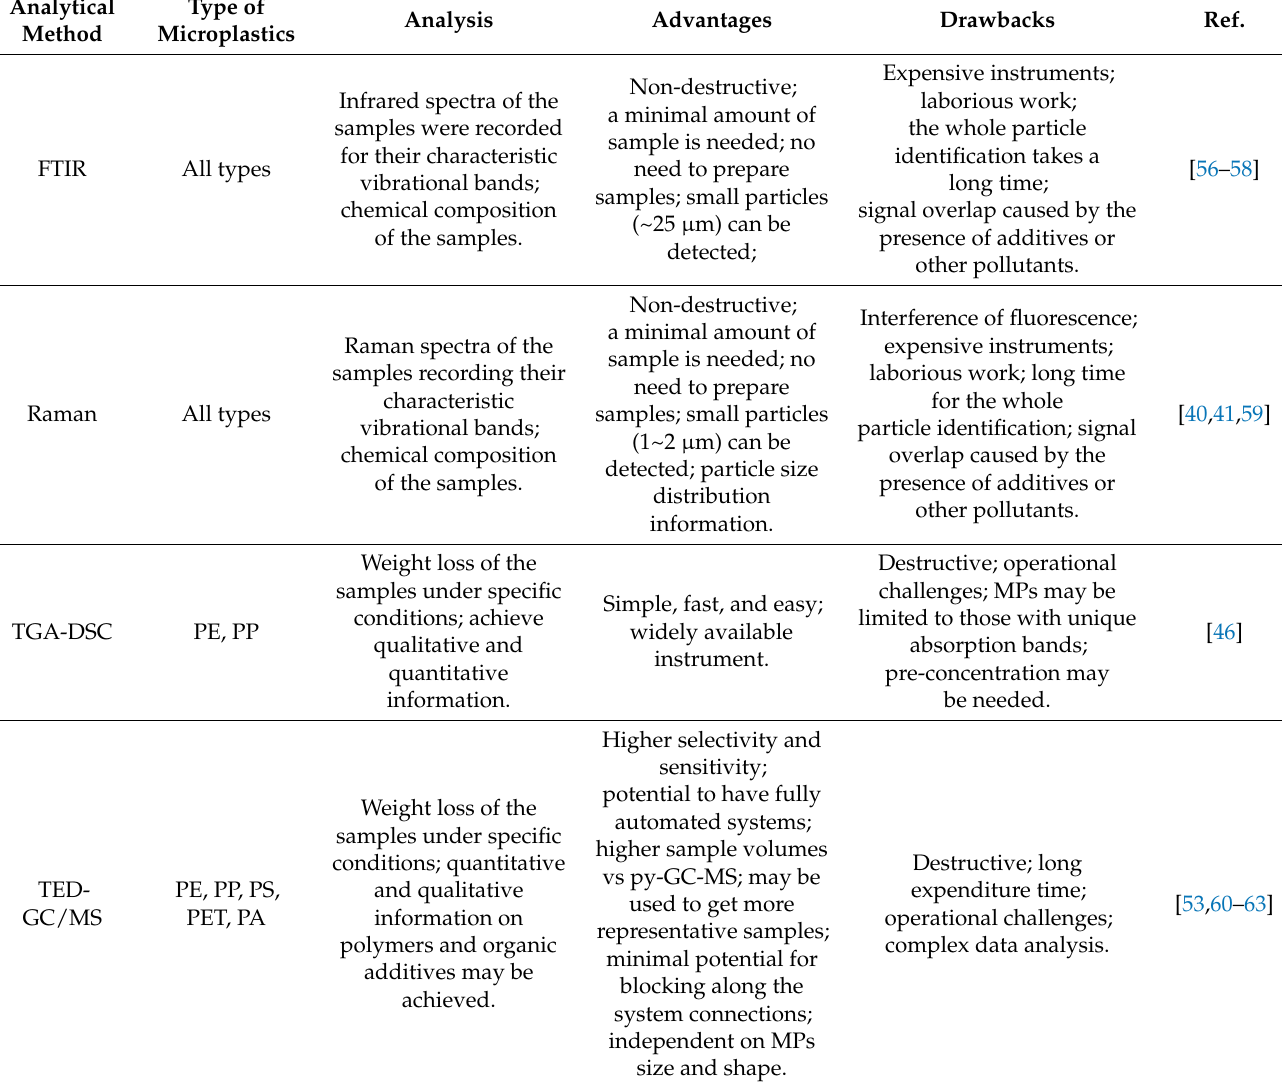
Table 1. Overview of thermal methods used for analyzing MPs with advantages and